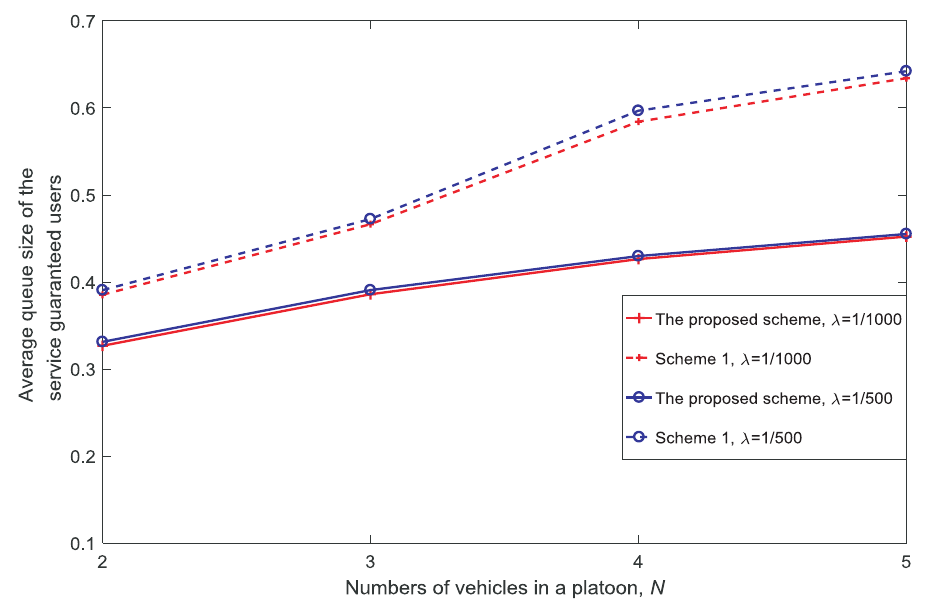
Figure 17. Average queue size of the service-guaranteed users for different numbers of vehicles in a platoon N ( d V = 10, K = 3, V = 10 )